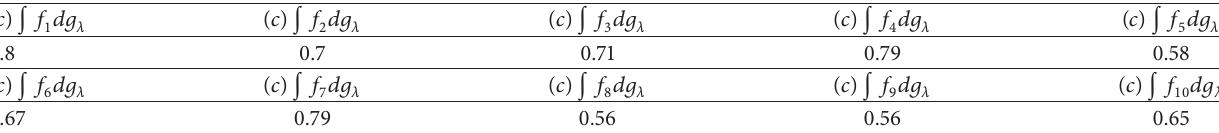
Table 3: Results of Example 16.